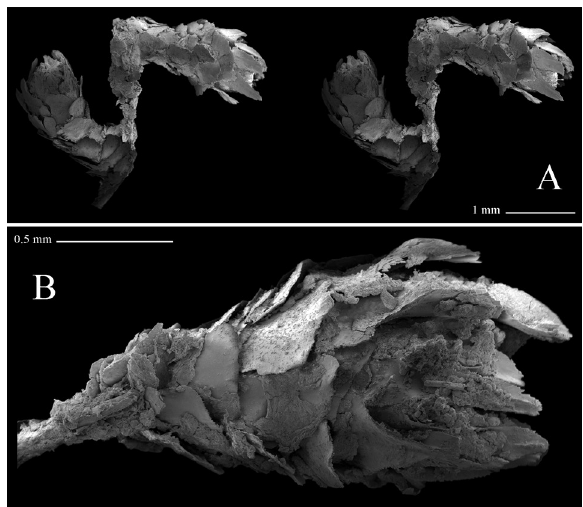
Fig . 8. – Thouarella dispersa Kükenthal, 1912, holotype (ZMB Cni 5468): A, polyps on lateral view, stereo pair; B, polyp on latero- adaxial